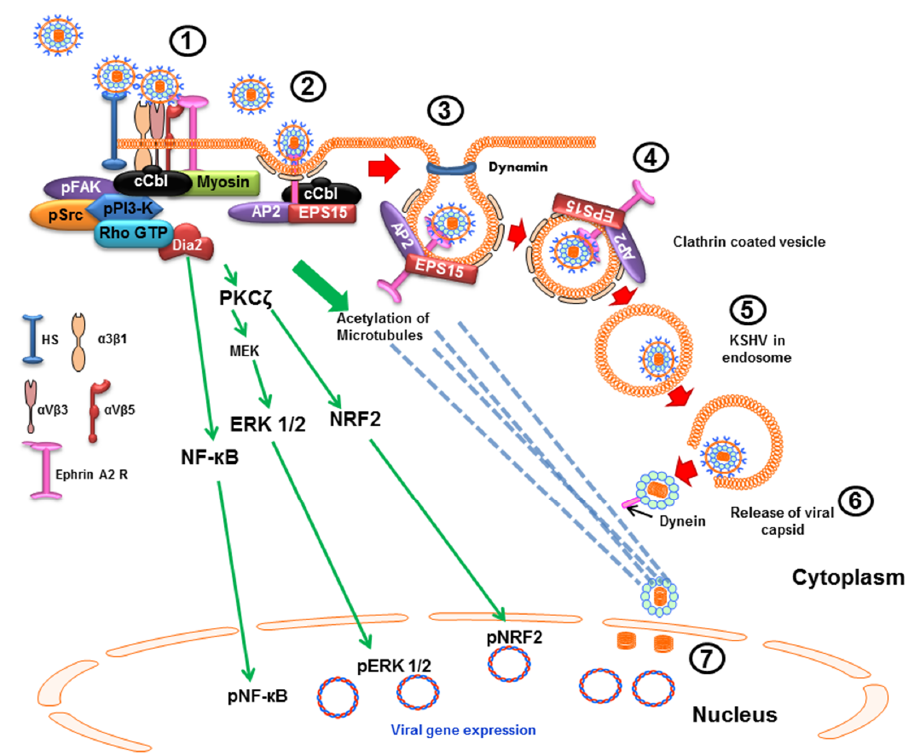
Figure 2. Schematic diagram depicting the clathrin mediated endocytosis of KSHV and trafficking in human foreskin fibroblast (HFF) cells. (1) The initial attachment of KSHV is with HS in the NLR regions of the plasma membrane which is followed by interactions with α 3 β 1, α V β 3, and α V β 5 integrins and with EphA2R. The association of EphA2R with integrins leads to the formation of an active signaling complex which leads to the induction of FAK, Src, and PI3 ‐ K signal molecules. (2) PI3 ‐ K activated c ‐ Cbl then polyubiquitinates EphA2R and recruits the accessory proteins Eps15 and adaptor protein AP ‐ 2, which is followed by (3 and 4) assembly of clathrin, formation of clathrin coated pits, internalization of KSHV into clathrin coated vesicles along with the activated signaling platforms and the associated molecules leading to the dynamin dependent release of the vesicles. (5) The internalized vesicles then recruit Rab5 and Rab7, and the virion envelope membrane fuses with the endosomal membrane mediated by the viral glycoproteins to release the capsid, which is transported (6) near the nuclear pore area resulting in genome entry into the nucleus. As in HMVEC ‐ d cells, (i) KSHV infection induced FAK, Src, PI3 ‐ K, Rho ‐ GTPase and ROS play roles in KSHV entry and actin remodeling; (ii) PI3 ‐ K, RhoA ‐ GTPase and Dia 2 molecules play roles in microtubule acetylation, reorganization and transport of capsid to the nuclear vicinity; and (iii) ERK1/2, NF ‐κ B and Nrf2 play roles in viral and host gene expression and modulation (7).